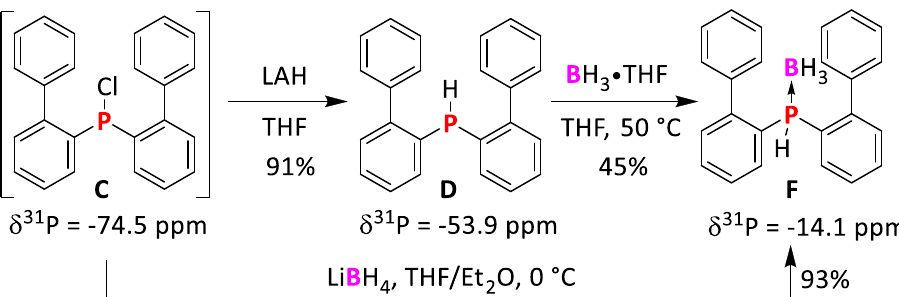
Scheme 6. Synthesis of the bis (biphenyl)phosphine borane ( F ) starting from chlorophosphine C